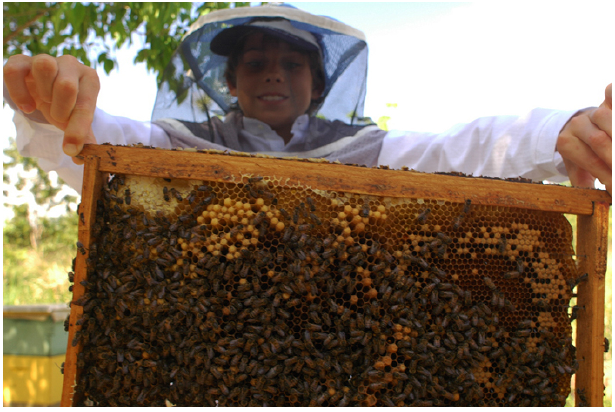
Fig. 7 . Active comb from Puntacana apiaries. (© Puntacana Ecological